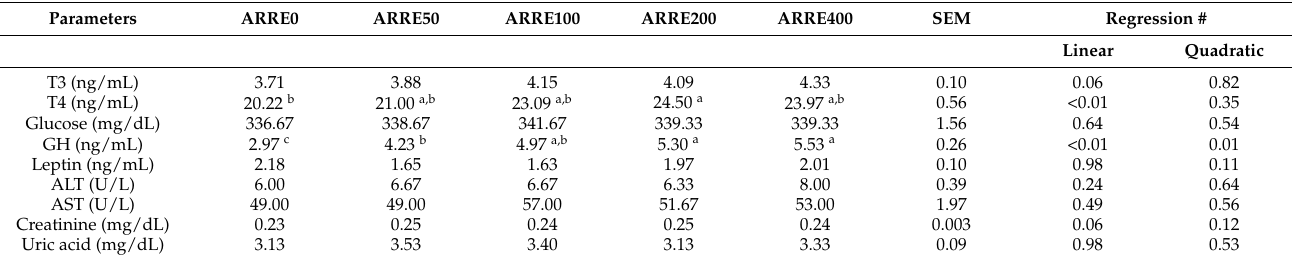
Table 7. The effect of dietary supplementation of ARRE on the blood biochemical parameters of broiler